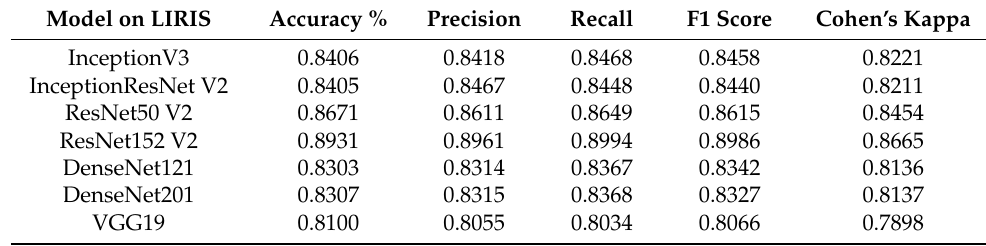
Table 4. Comparison of Model wise metrics on LIRIS.